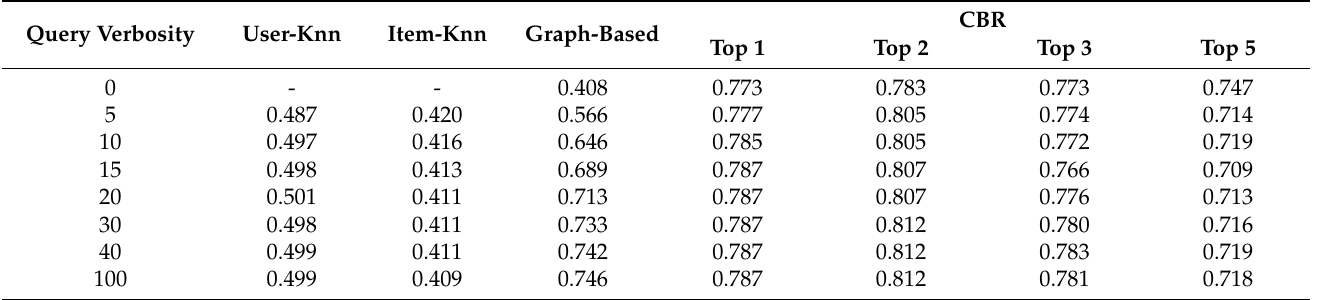
Table 2. Experiment 1: MAP values for individual recommendation techniques for different configu-